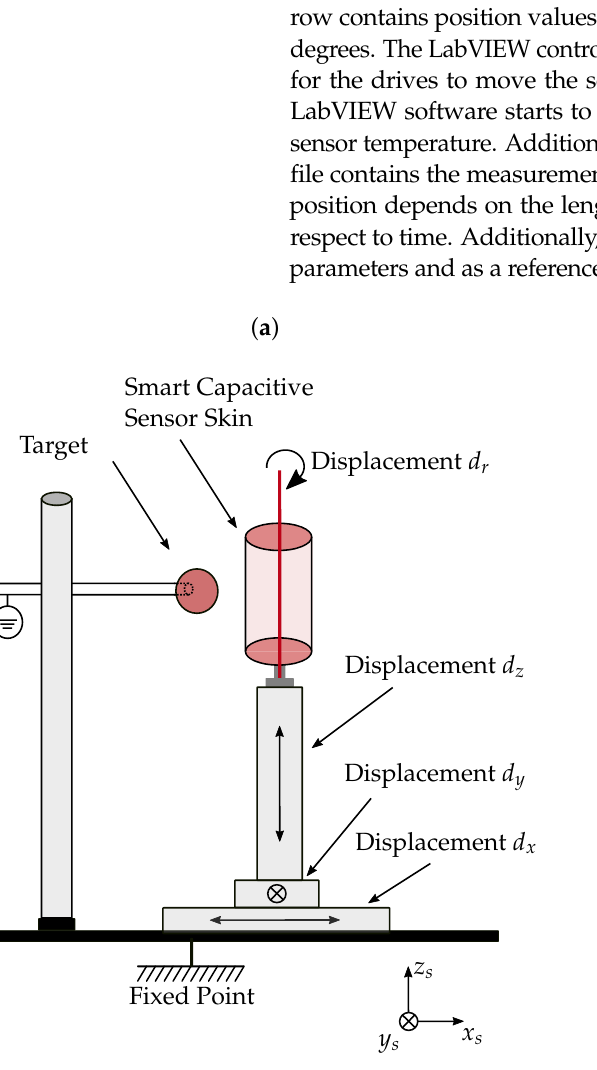
Figure 3. Drawing of experimental setup with coordinate system ( a ). Picture of test bench with sensor mounted ( b ). Algorithm 1 Acquisition procedure to capture sensor samples at specified